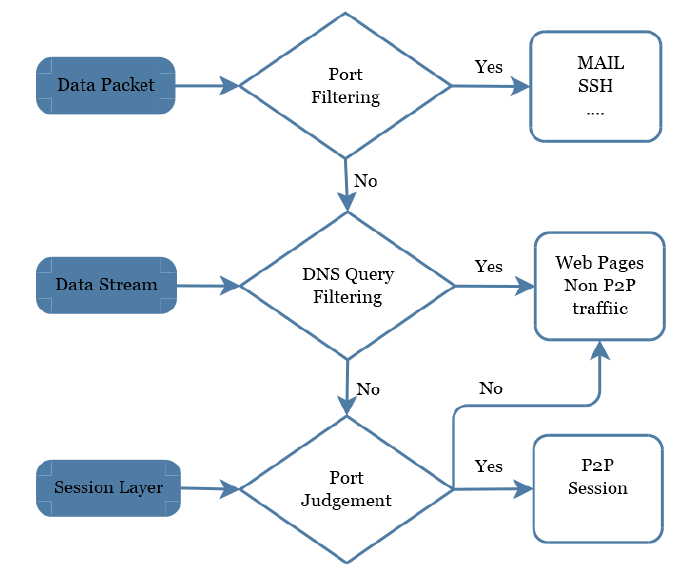
Figure 5. Second layer of traffic